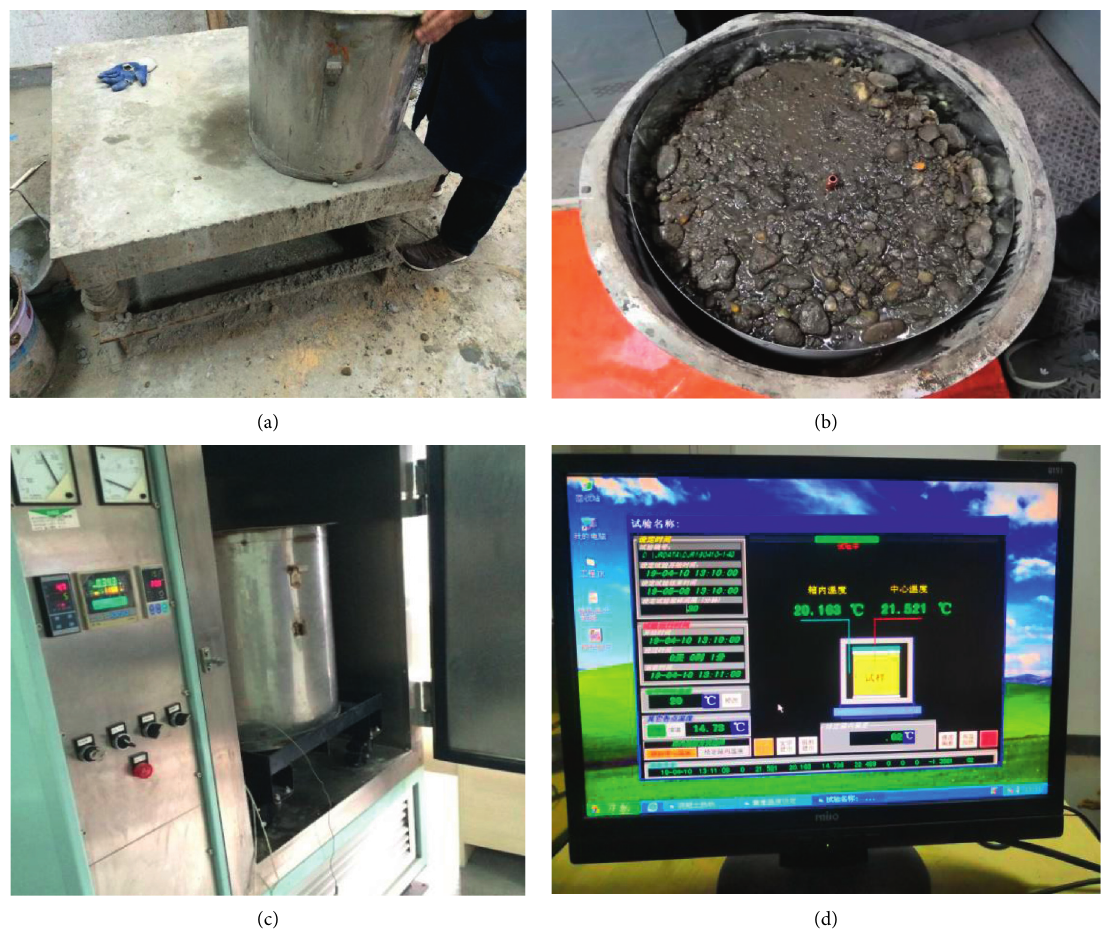
Figure 3: Sample preparation process. (a) Vibration of CSG material. (b) Insertion of red copper temperature tube. (c) Putting container into adiabatic temperature rise box. (d) Data acquisition system.